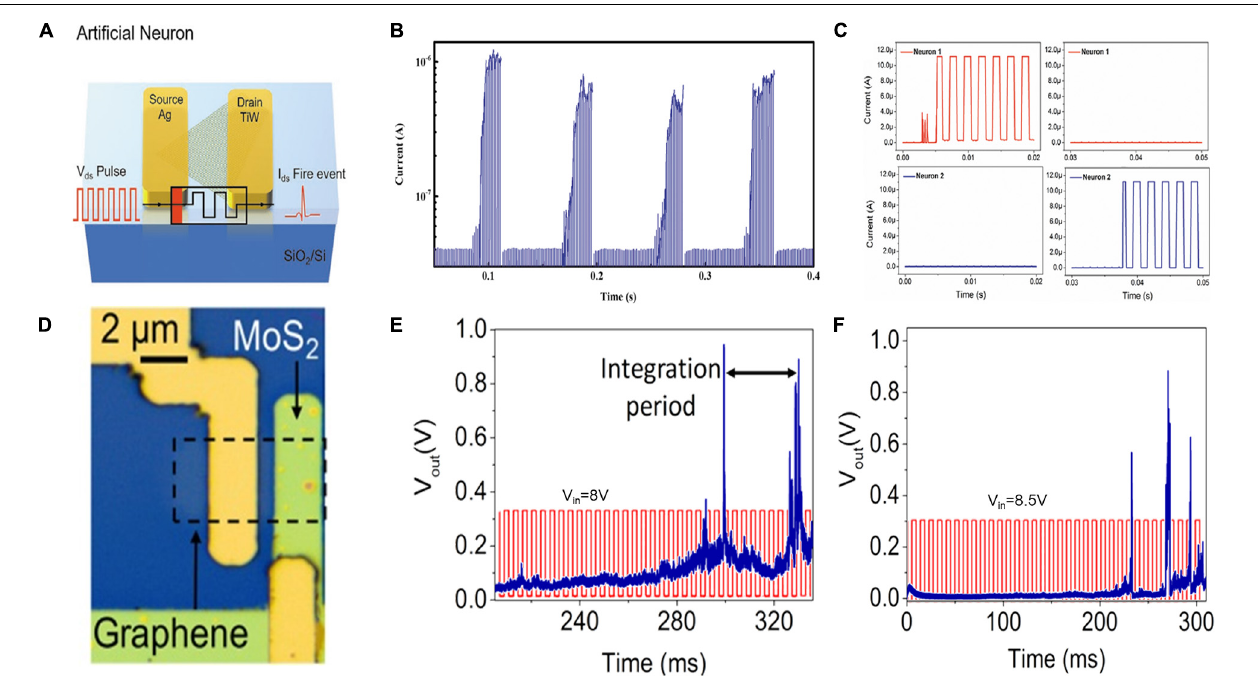
FIGURE 5 | (A) Schematic of a planar artificial neuron with an Ag/MoS 2 /TiW structure. (B) Realization of leaky integrate-and-fire behavior of MoS 2 -based memristive device under a continuous pulse train. (C) The classification result based on the presence and absence of neuron firing (Hao et al., 2020). (D) Optical image of the MoS 2 /graphene threshold switching (TS) device. Output spikes under an impulse train with amplitude modulation at (E) 8 V and (F) 8.5 V. The integration time, refractory period, and stochastic output behavior are obtained (Kalita et al.,